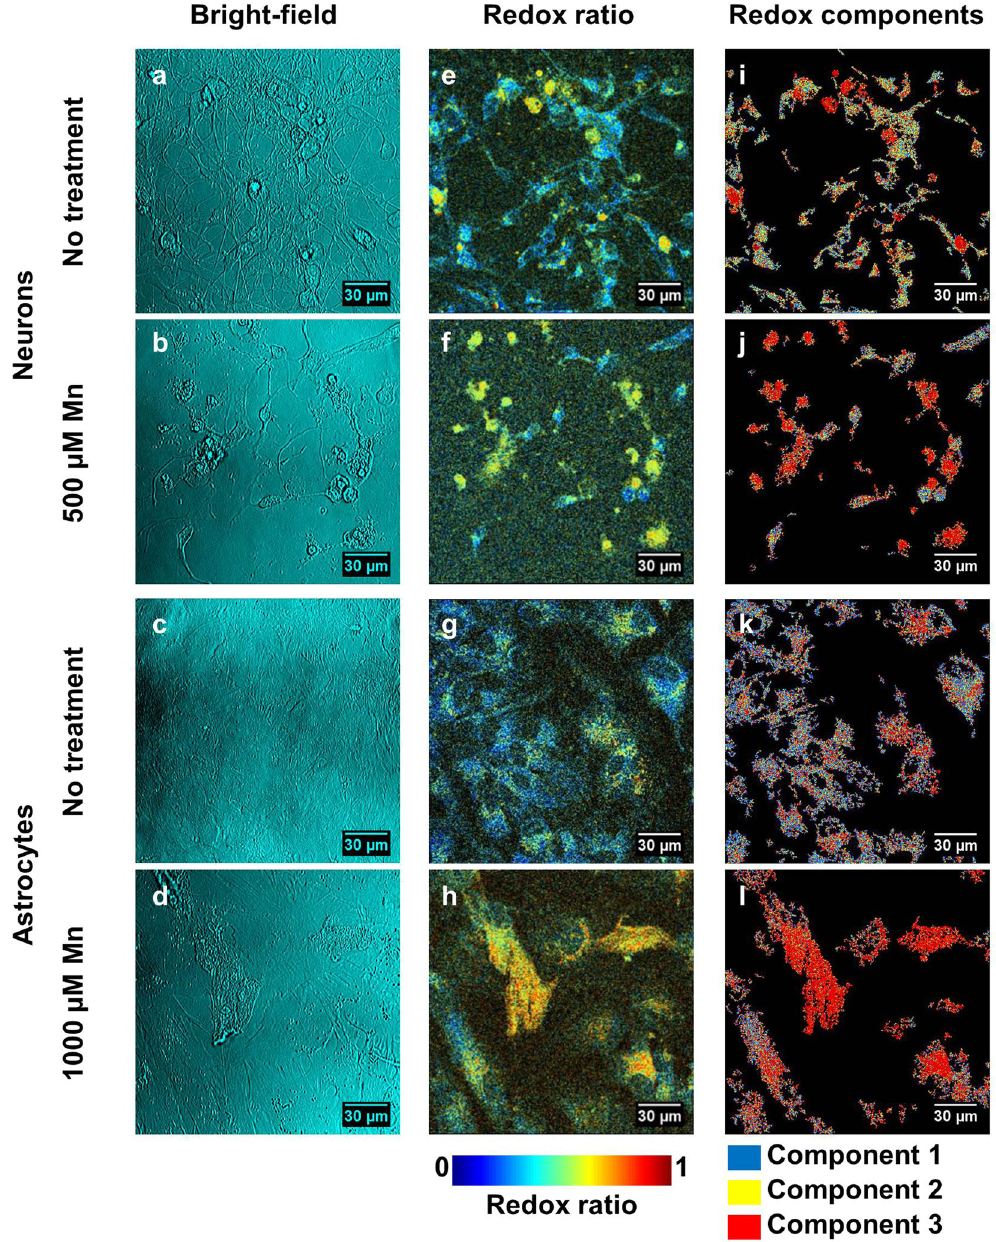
Figure 5. Images revealing cell responses to Mn toxicity. ( a–d ) Bright-field images show morphological changes resulting from Mn toxicity. Neurons treated with Mn ( b ) show axon loss and nuclear blebbing relative to the untreated cells ( a ). Astrocytes treated with Mn ( d ) have a rougher appearance than the untreated cells ( c ). ( e–h ) Redox ratio maps reveal increasing redox ratio with Mn treatment in neurons ( f ) and astrocytes ( h ) relative to controls ( e,g ). ( i–l ) When pixels are colored according to their corresponding redox ratio components, untreated neurons ( i ) and astrocytes ( k ) show a heterogenous mixture of all three components, while treated neurons ( j ) and astrocytes ( l ) are increasingly dominated by component